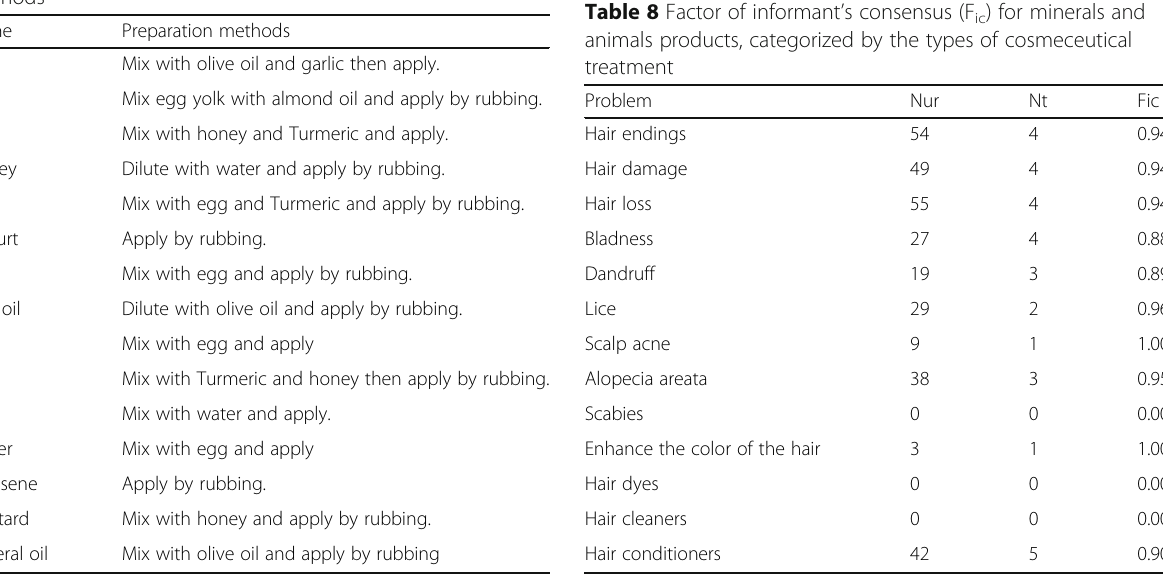
Table 7 Minerals and animal products and their preparation methods